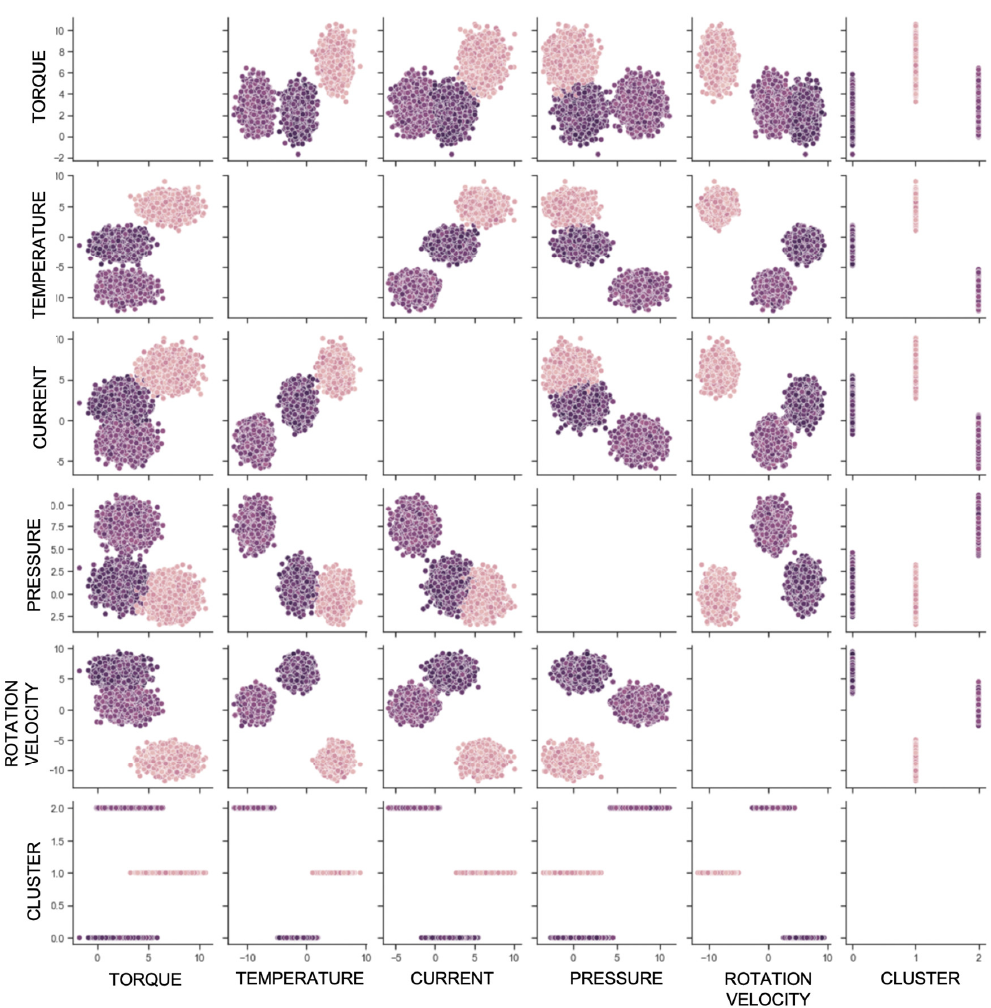
Figure 11. Matrix of the scattering plots of five variables and the state of operation.